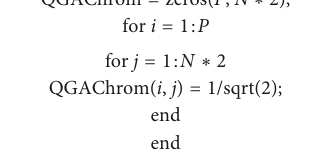
Table 2: Values of sig.